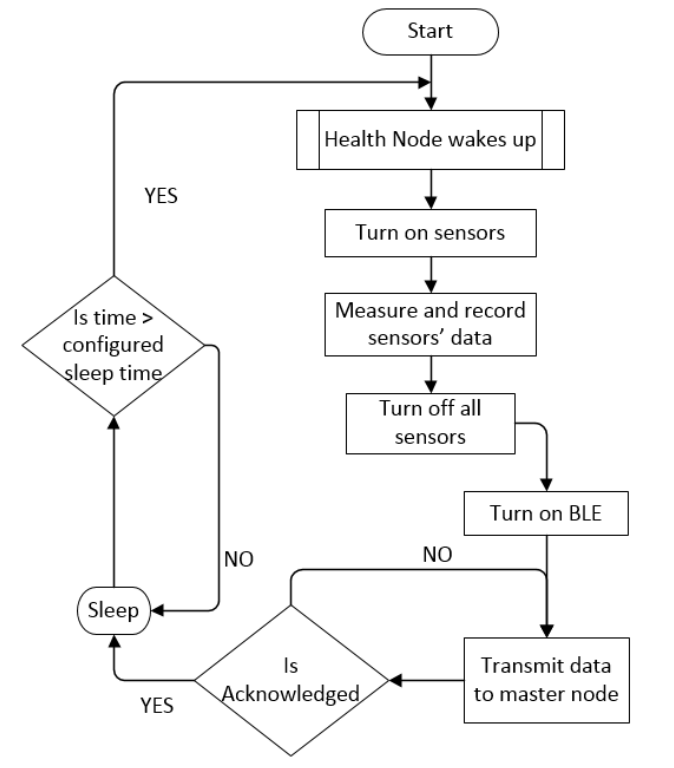
Figure 7. Software flowchart for the Health